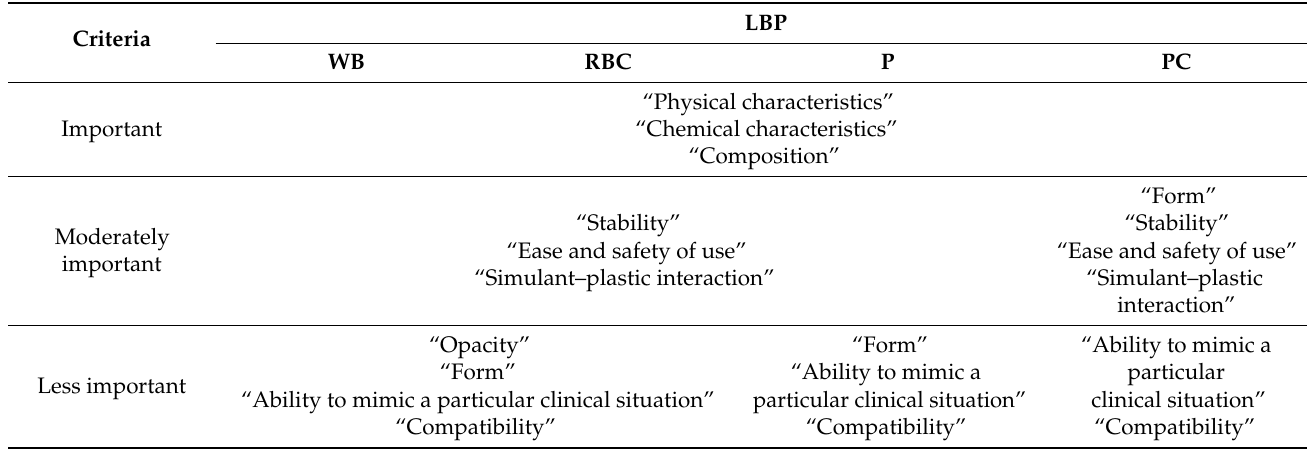
Table 4. Three-level classification of the criteria from the nominal group’s qualitative